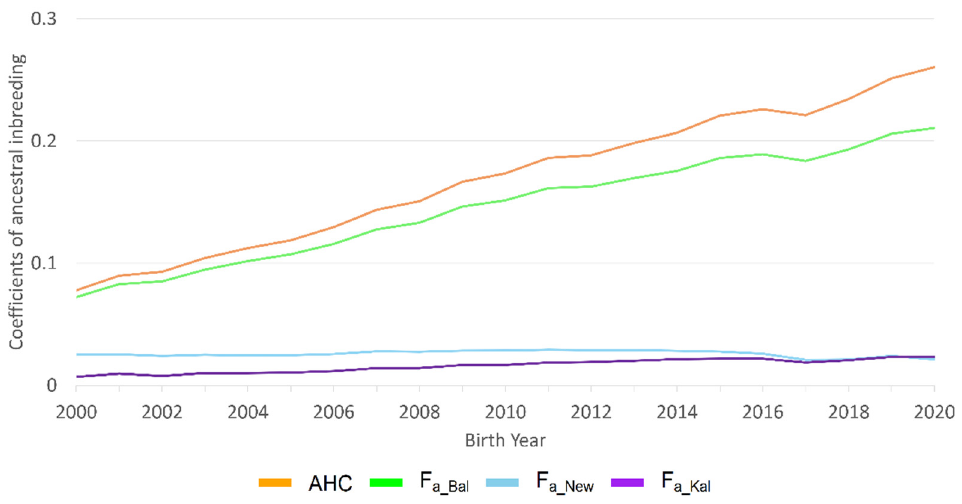
Figure 2. Ancestral inbreeding according to Ballou (F a_Bal ), ancestral (F a_Kal ) and new (F New ) inbreed- ing according to Kalinowski et al. and the ancestral history coefficient according to Baumung et al. (AHC) of Deutsch Drahthaar dogs for the birth years 2000 to 2020.